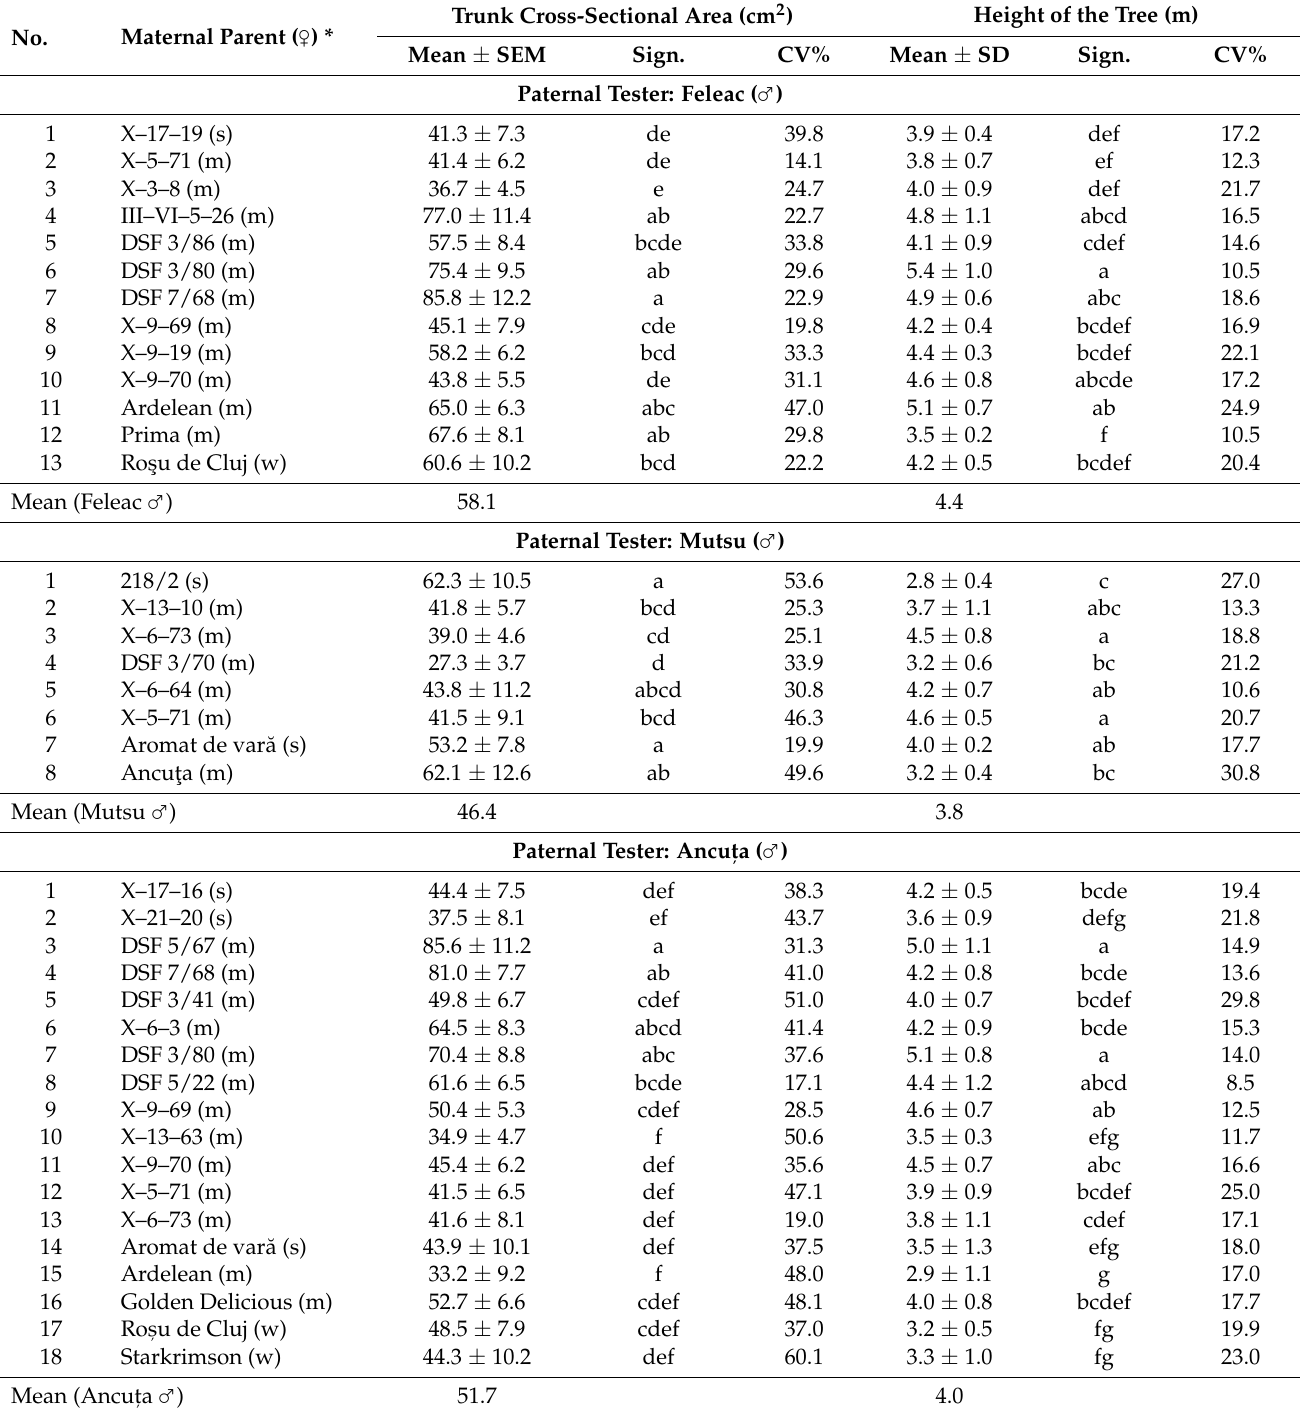
Table A1. Trunk cross-sectional area (cm 2 ) and tree height (m) in F 1 apple hybrids in the offspring of testcross hybridization with the five cultivars used as paternal